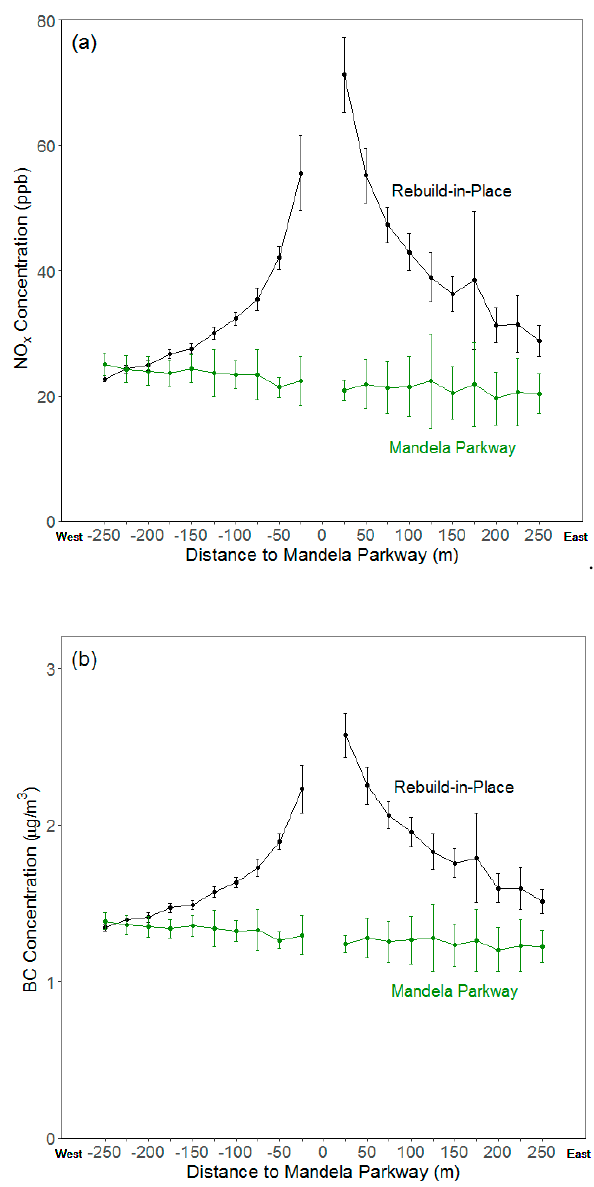
Figure 3. Mean annual average concentrations of ( a ) NO x and ( b ) BC versus distance from the Mandela Parkway alignment. Each data point in the figure represents an averaged value for all measurements within a 25 m distance band. Negative distances are to the west; positive values are to the east. Uncertainty estimates indicate 95% confidence levels.